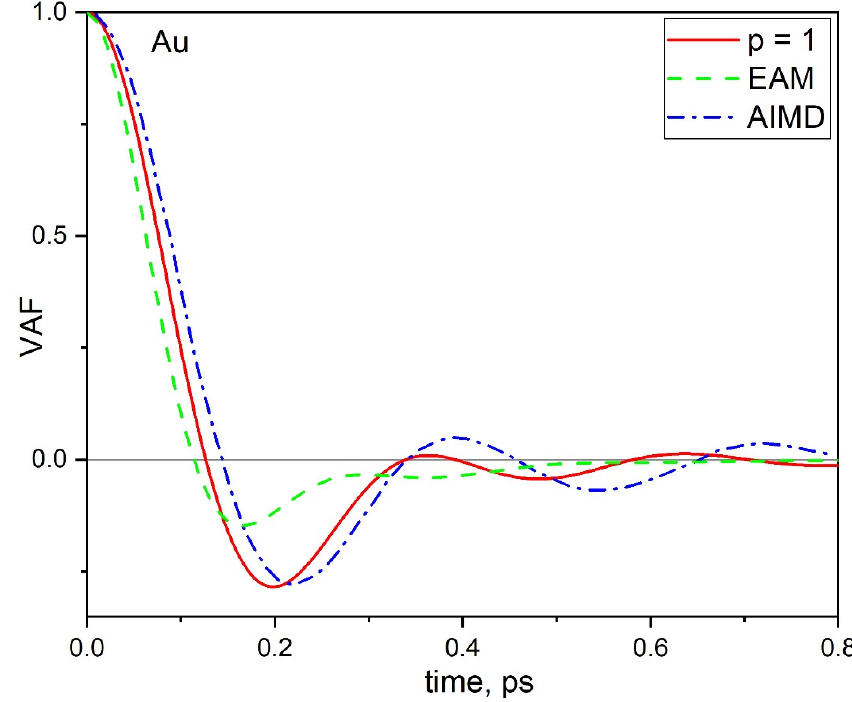
1 = p in comparison